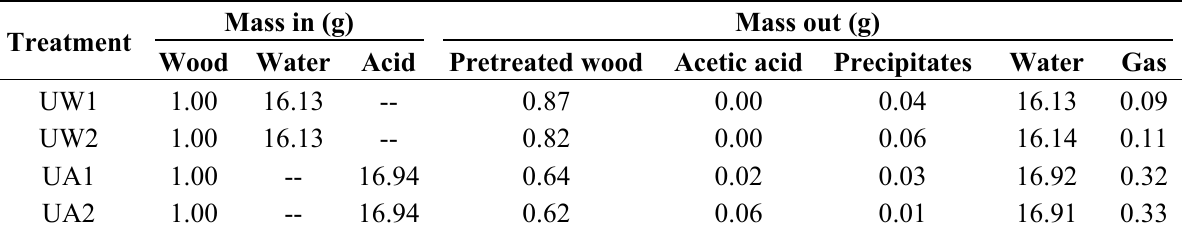
Figure 2. Van Krevelen diagram for untreated and pretreated biomass. Table 4. Mass of reactants and products in HTC without and with diluted